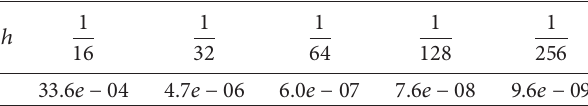
Table 10: Maximum errors for the Sine-Gordon